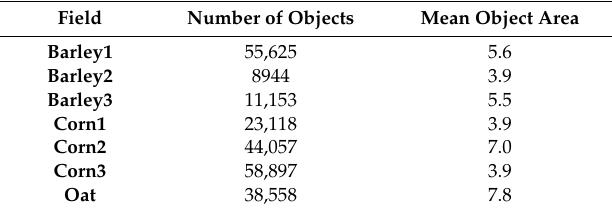
Table 4. Number of objects and objects mean area (m 2 ) per field.